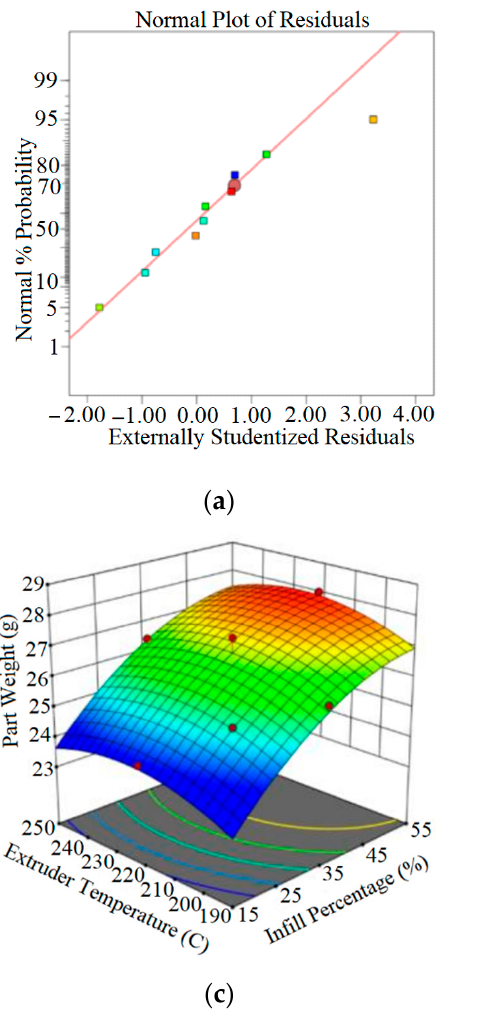
Figure 7. Response surface plots for SW: ( a ) normal plot of residuals, ( b ) predicted vs. actual output, ( c ) response surface plot, and ( d ) contour plot of IP and ET.